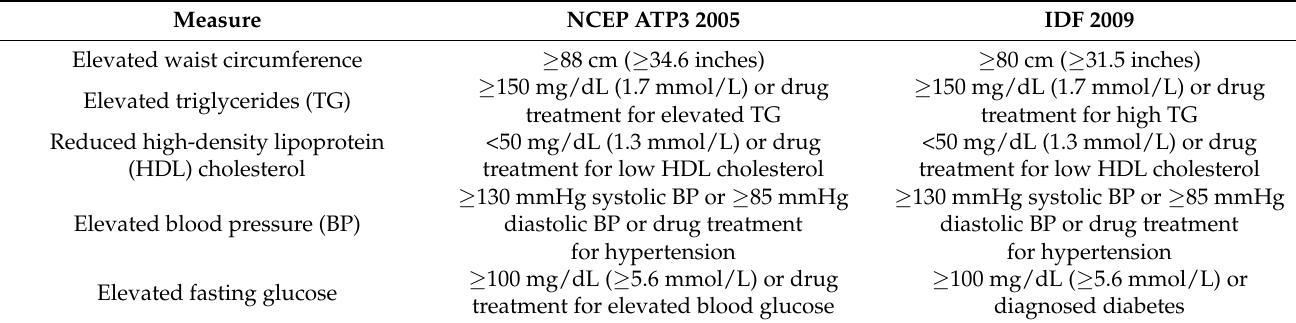
Table 1. The criteria for the diagnosis of